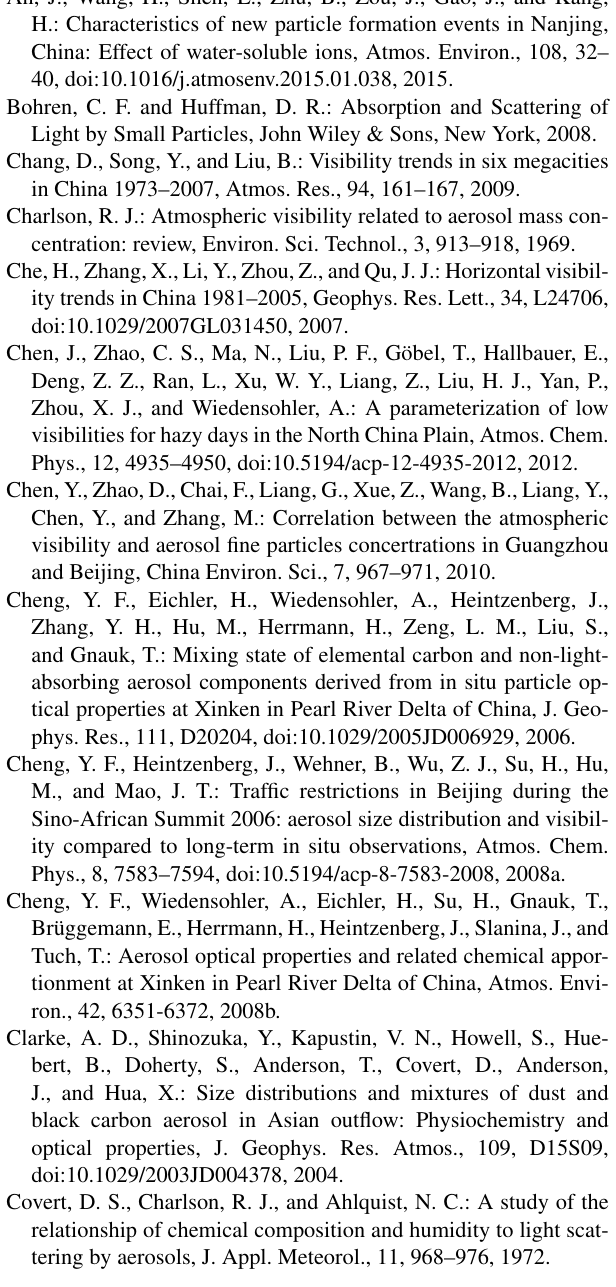
Figure 11. Relationship between the contribution fraction of ex- tinction coefficients in different size segments and relative humidity